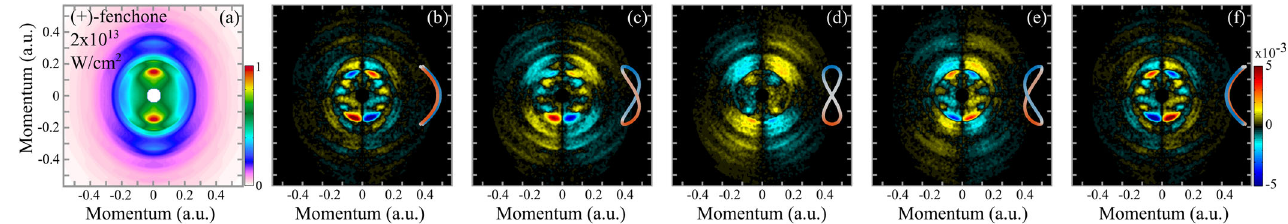
FIG. 11. Experimental data without up-down antisymmetrization. (a) Normalized projection in the y - z plane of the photoelectron angular distribution for fenchone ðþÞ with a fundamental field of 2 × 10 13 W cm − 2 . (b) – (f) Evolution of the ESCARGOT signal as a function of the relative phase φ between the two components of the ionizing field. The shape of the two-color field, colored according to the instantaneous chirality, is shown next to each image. The ESCARGOT signal is normalized to the maximum of the photoelectron spectrum in (a).